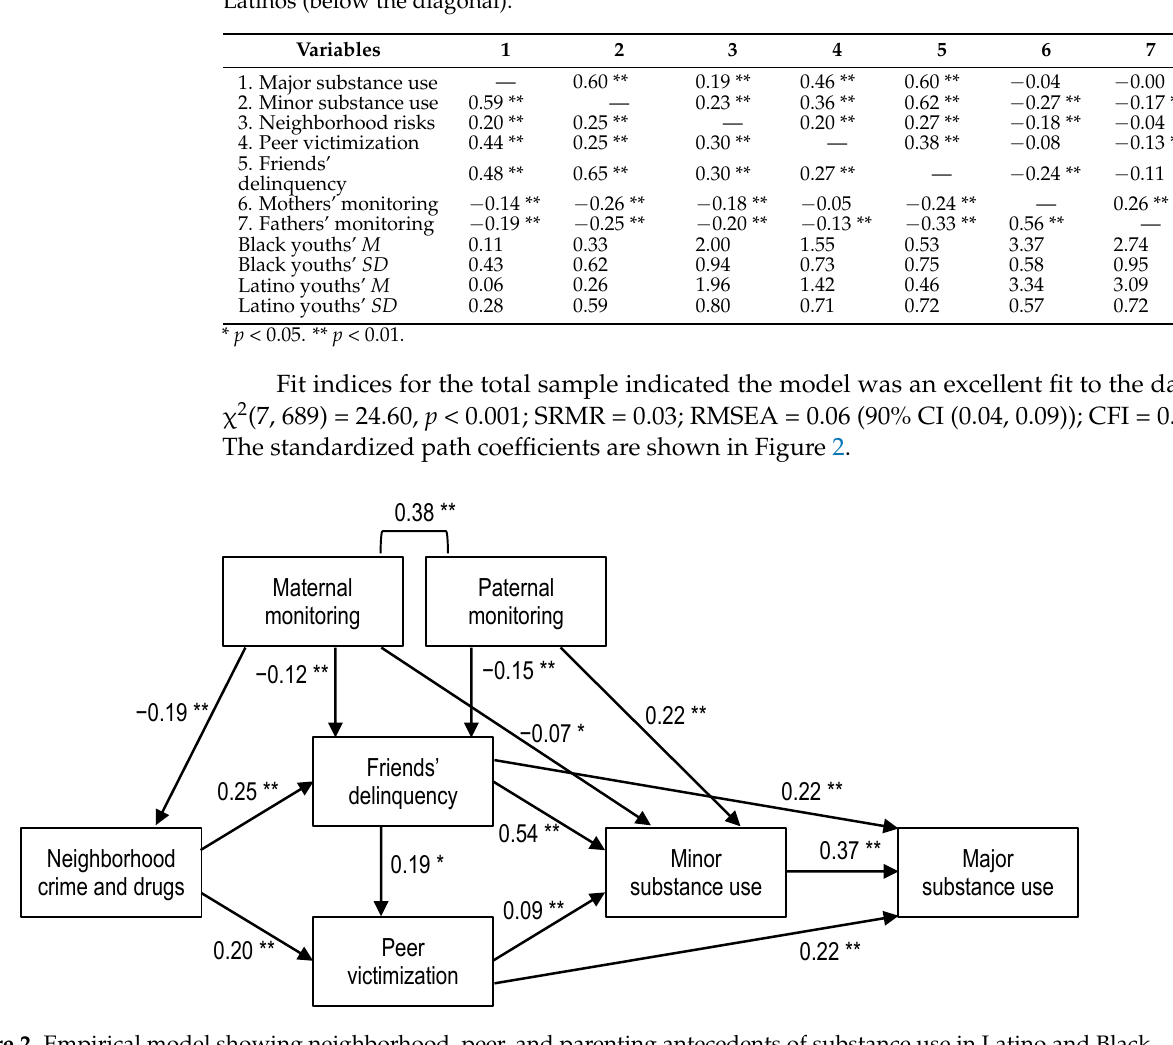
Figure 2. Empirical model showing neighborhood, peer, and parenting antecedents of substance use in Latino and Black adolescents. Standardized betas are shown. Chi-square = 24.60, p < 0.001, comparative fit index (CFI) = 0.982, root mean square error of approximation (RMSEA) = 0.06. * p < 0.05. ** p < 0.01. For the first multiple-group model on genders, all paths were free to vary. This model fit the data well: χ 2 (14, 689) = 32.26, p = 0.004; SRMR = 0.03; RMSEA = 0.06 (90% CI (0.03, 0.09)); CFI = 0.98. The model in which all paths were constrained did poorly in